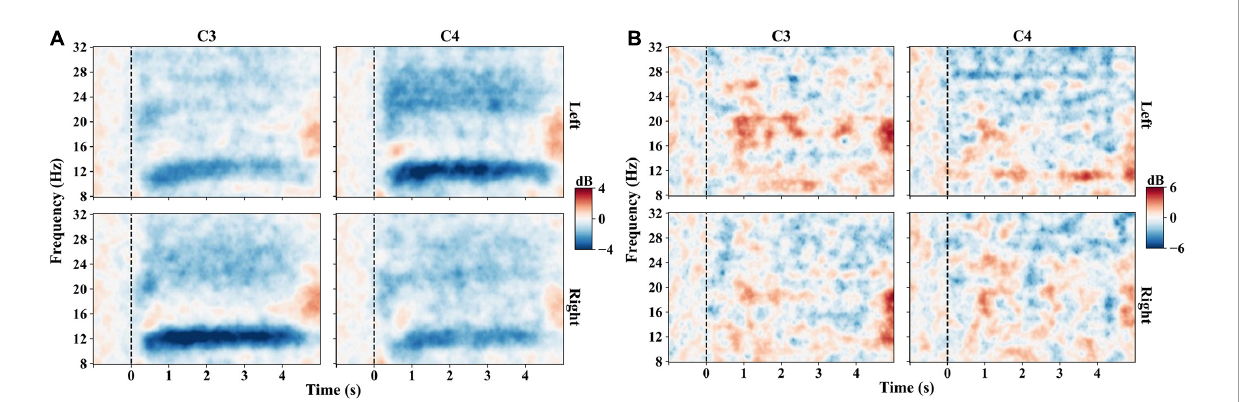
FIGURE3 Time-frequency maps on C3 and C4 channels of experiment one. Left indicates the left-hand MI task, and right indicates the right-hand MI task. Blue indicates the ERD, red indicates the ERS, and black dashed lines indicate the task onset. (A) Time-frequency maps averaged across trials of all subjects. The left-hand MI task induces a stronger mu-band ERD on C4 than on C3, and the right-hand MI task induces a stronger ERD on C3. (B) Time-frequency maps averaged across trials of subject S4, showing little ERD patterns when performing MI tasks.